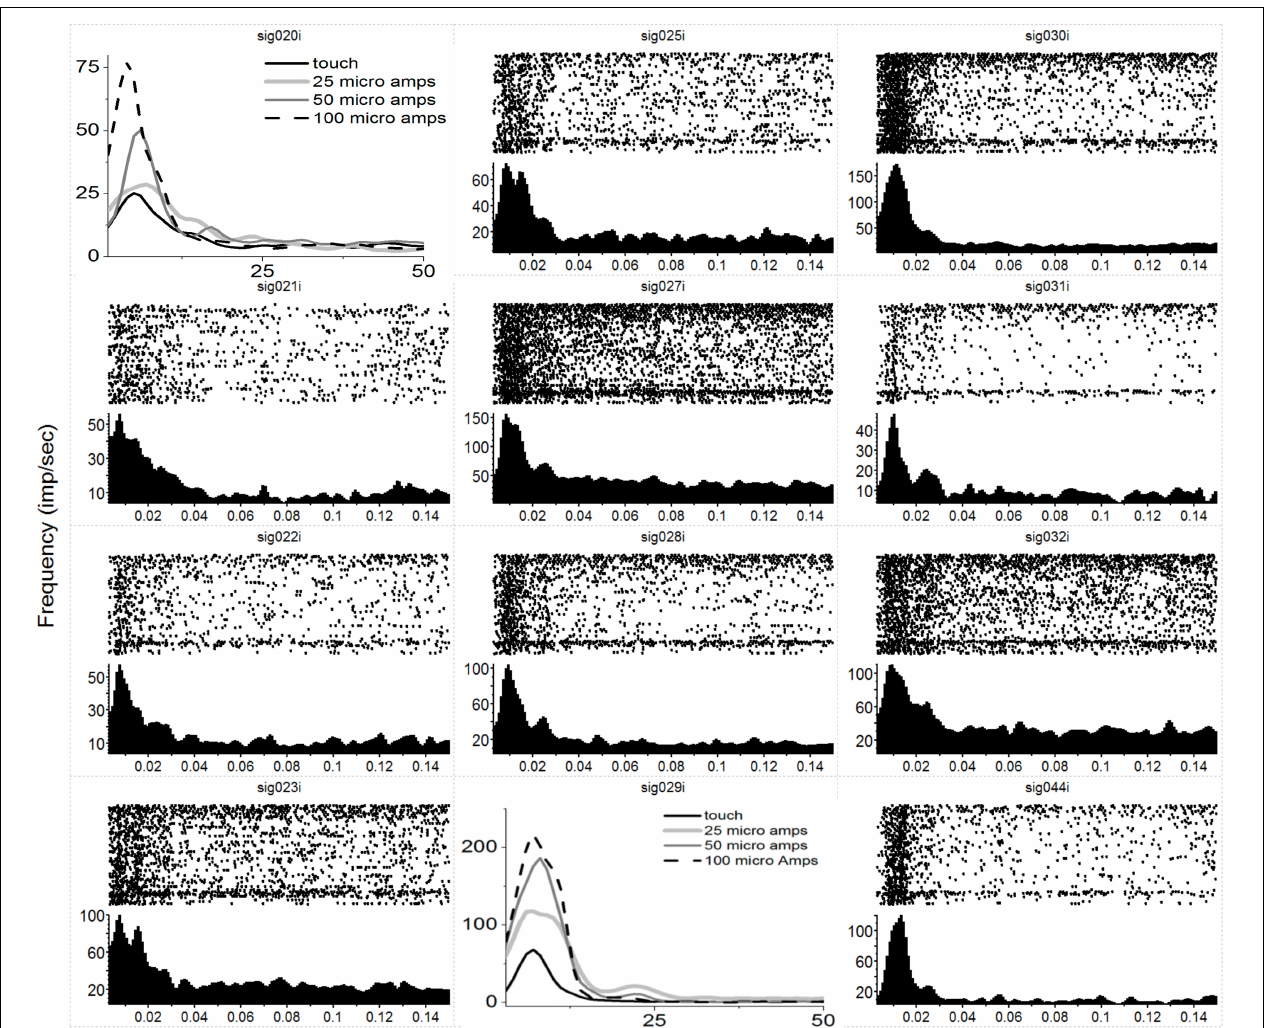
FIGURE 2 | Neural responses in S1 to MiSt in the VPL thalamus. Each peri-stimulus raster and histogram pair are in response to a 25 µ A single biphasic bipolar pulse stimuli in the VPL. For panels showing multiple histograms, the current used is labeled in the key, and responses from the mechanical touch were shifted in time to align with the MiSt-induce responses; the x -axis for these plots is bin number at 3 ms bins. Processing was as in Figure 1 . Note that most responses are on the order of 15–20 ms. As this was in response to MiSt, the responses are all shifted to the left; they occur sooner than would be the case if due to touch on the periphery as there is no peripheral transmission